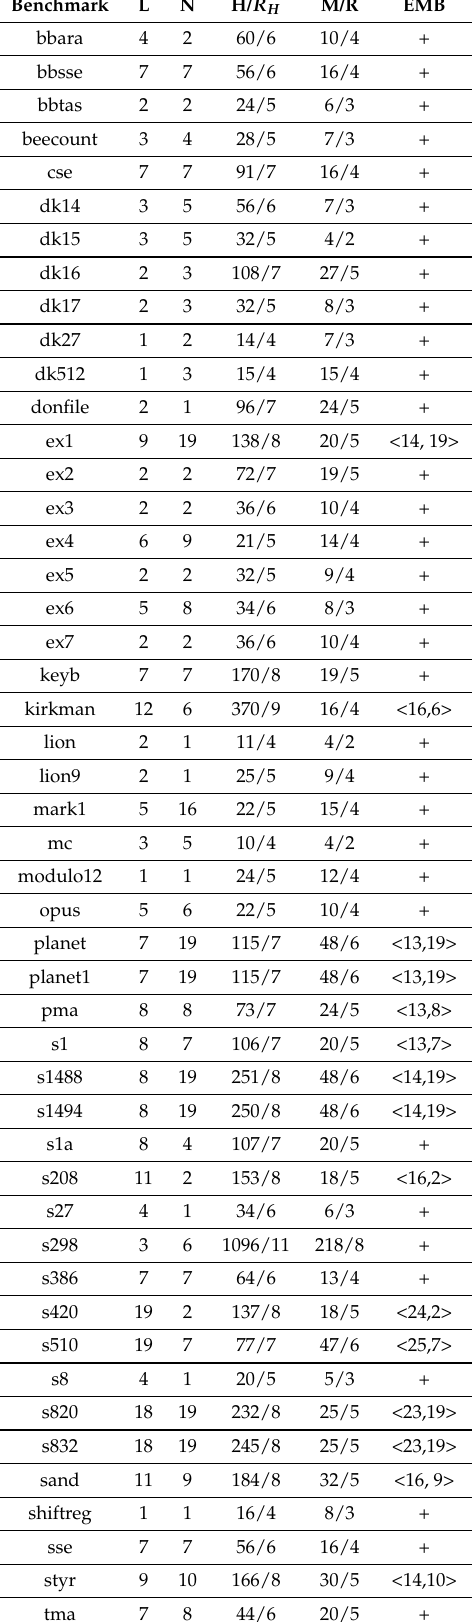
Table 7. Characteristics of Mealy FSM